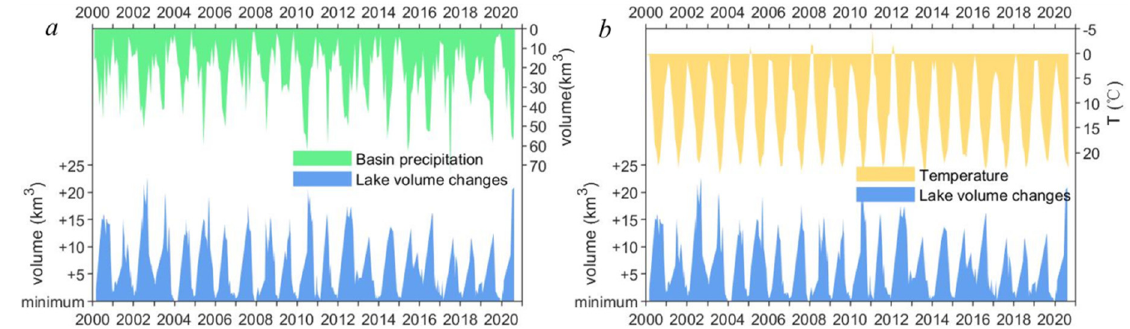
Figure 12. Comparisons of the lake storage changes and the equivalent precipitation ( a ) and temperatures ( b ) in the basin on a monthly scale. Because the volume of the smallest inundated area during 2000–2020 was unknown, the unknown volume was considered as the minimum.